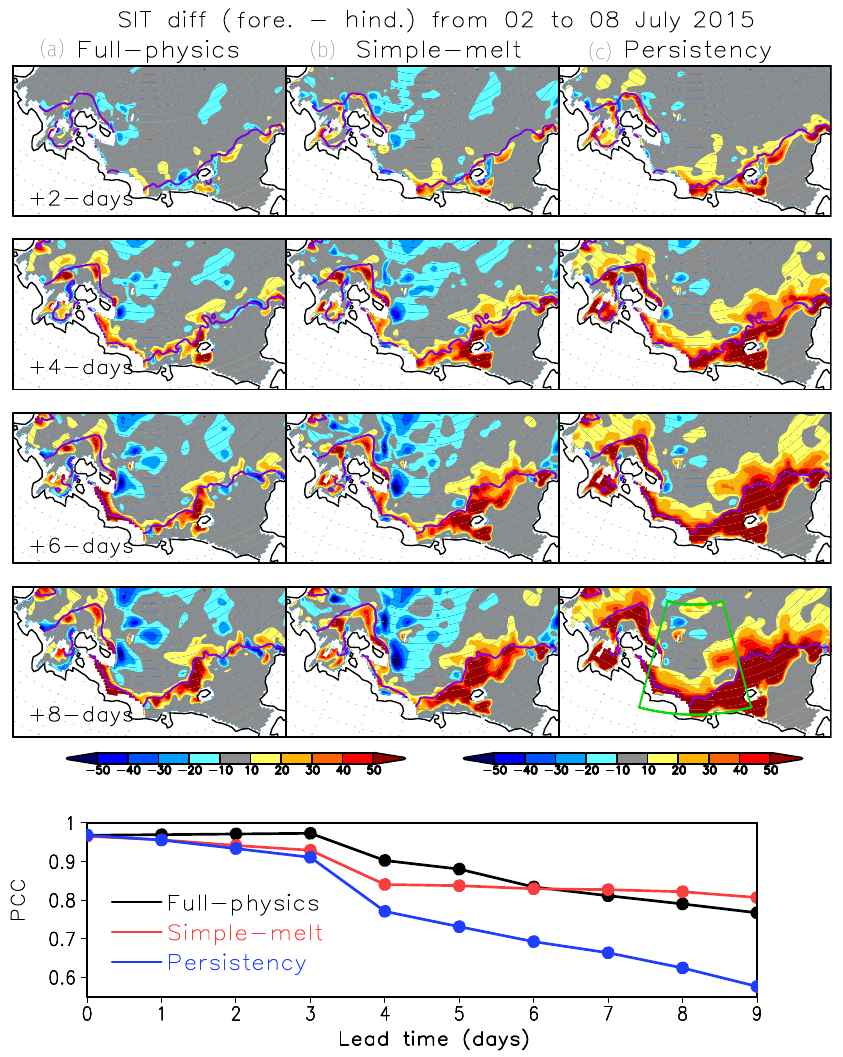
Figure 11. Temporal evolution of SIT differences (centimetres; colours) between the forecast and analysis data at lead times increasing from + 2 to + 8 days, initialized on 2 July 2015. In each panel, the sea ice edge of the analysis, defined by 30% SIC, is shown. Corresponding PCCs for the full physics model (black), a simple melting model (red) and persistency (blue) in the ESS (right-lower panel of the time evolution) are shown in the lower